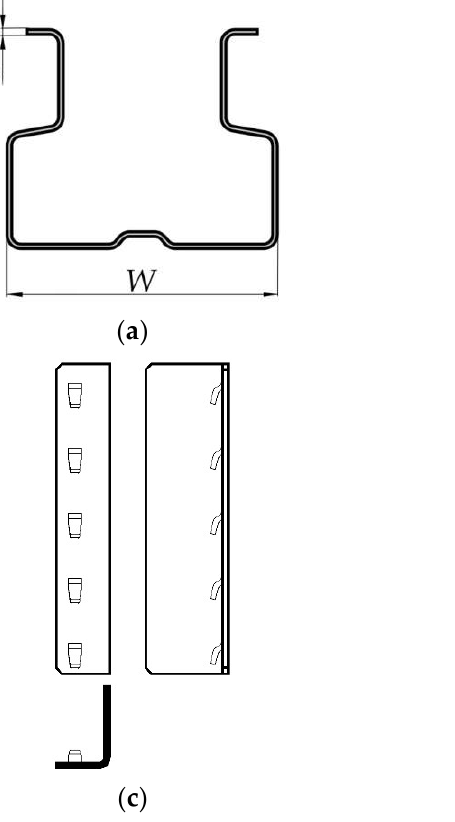
Figure 4. Elements of the upright-connector-beam assemblies tested: ( a ) upright sections; ( b ) beam section; ( c ) connector with 5 tabs; ( d ) sketch of the tested assembly.